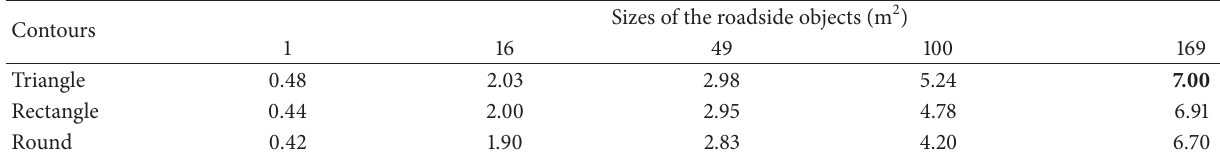
Table 7: The legibility assessment scores of the objects under 120km/h.